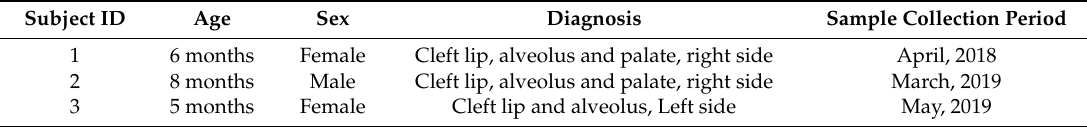
Table 1. Demographic data of the subjects in this study.